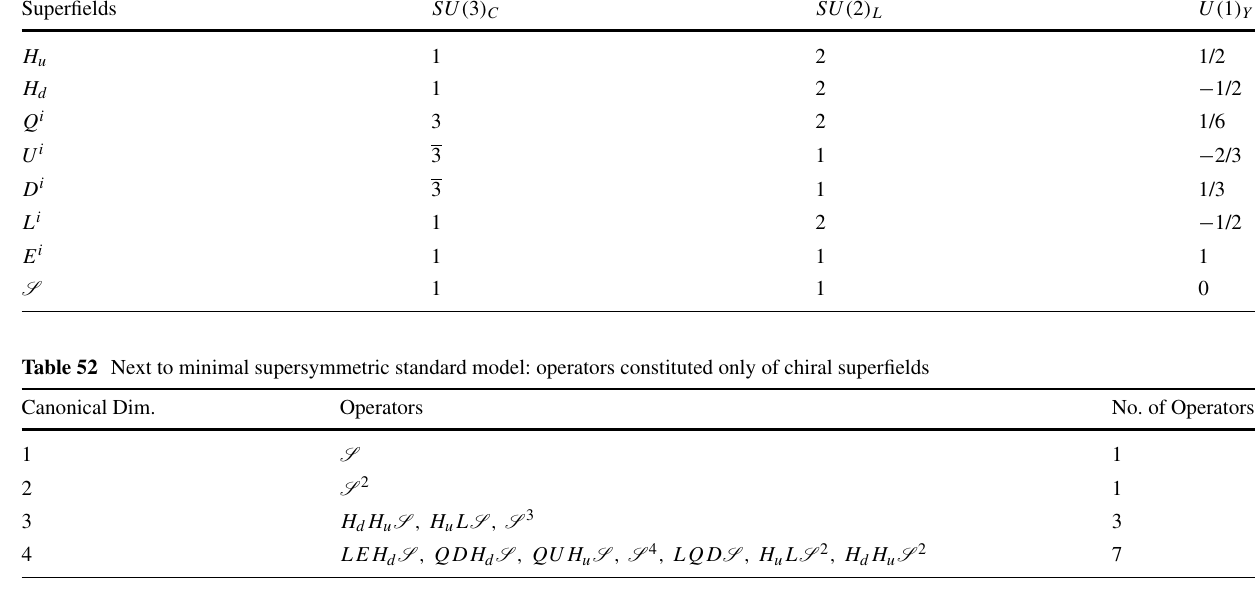
Table 51 Next to minimal supersymmetric standard model: quantum numbers of superfields under the gauge groups. Internal symmetry indices have been suppressed. i = 1 , 2 ,.., N f is the flavour index Superfields